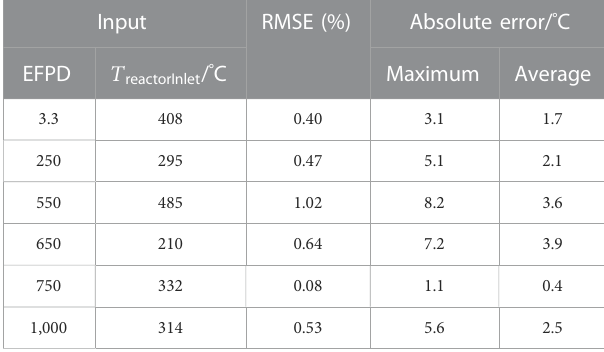
TABLE 4 Comparison between ROM and CFX (fuel rods